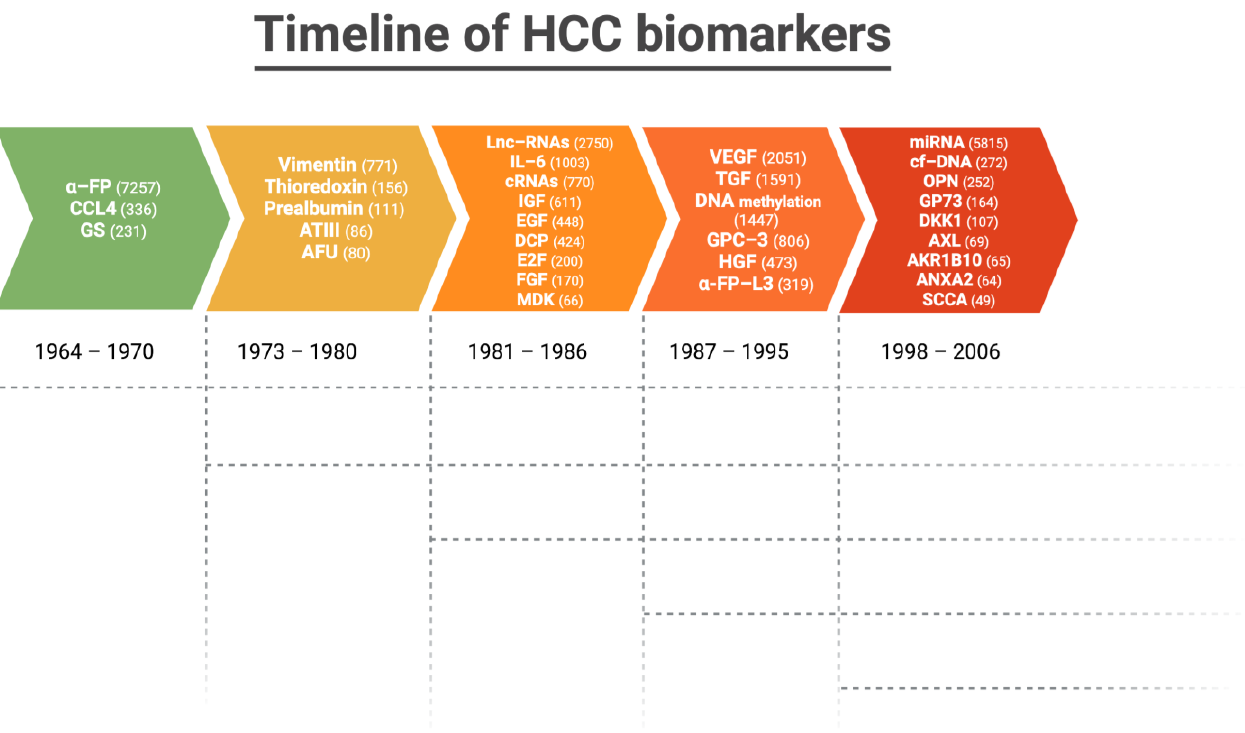
Figure 3. Timeline and number of articles (in parenthesis) published on the most validated biomarkers in hepatocellular carcinoma up to 2023.